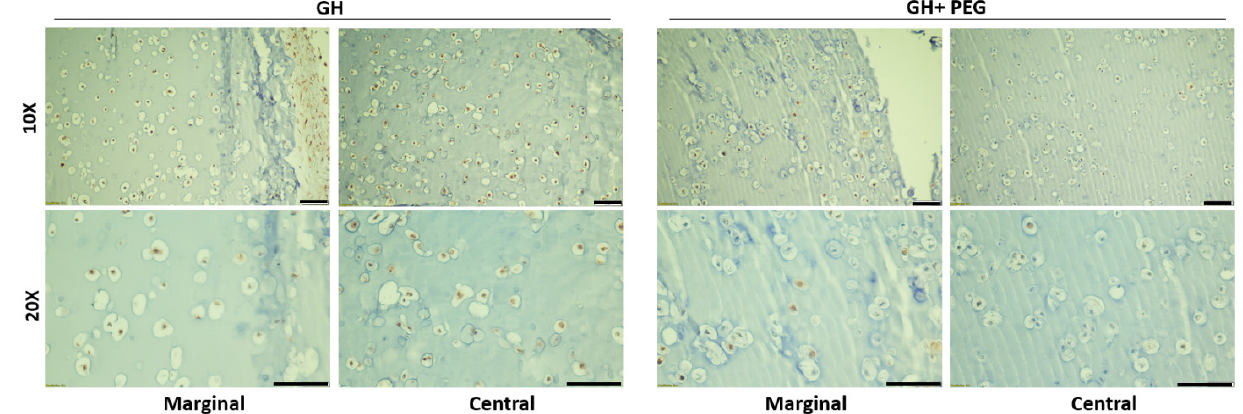
Figure 5. ki67 immunohistochemistry (IHC). Bar = 100 μ m.